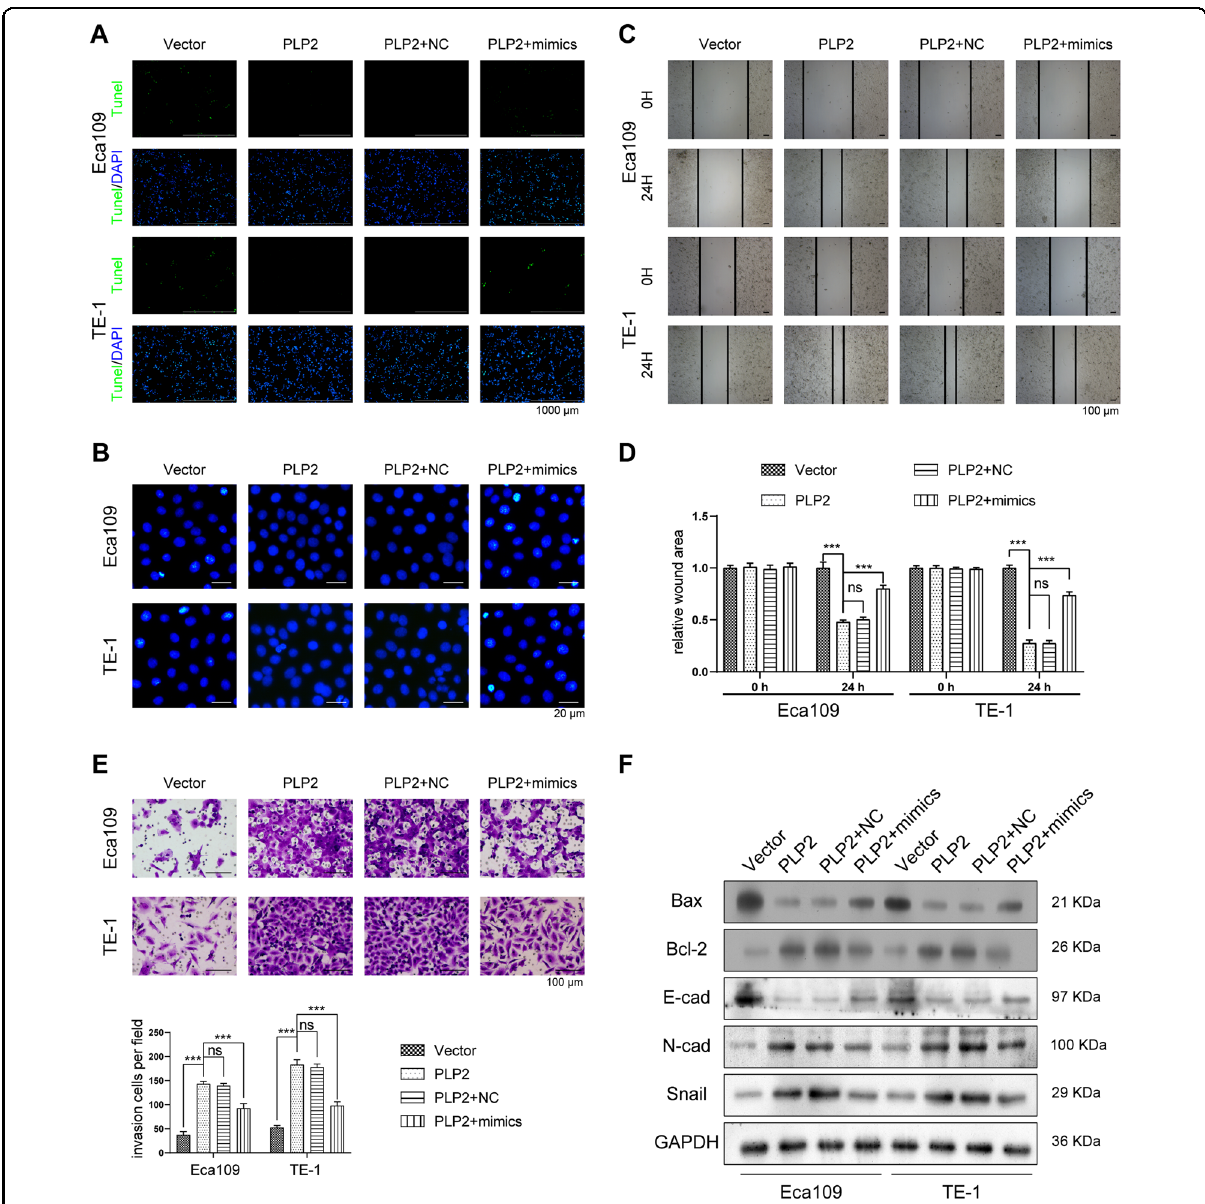
Fig. 5 Restoration of miR-124 weakened PLP2-caused ESCC cell metastasis and promoted cell apoptosis. After overexpression of PLP2 with or without miR-124 mimics transfection, the apoptosis of Eca109 and TE-1 cells was determined by A Hoechst staining, scale bars, 1000 μ m. B TUNEL assay, scale bars, 20 μ m. The ability of migration and invasion was estimated by C , D scratch wound assay, scale bars, 100 μ m. E transwell assay, scale bars, 100 μ m. F The key proteins in apoptosis pathway and EMT pathway analyzed by WB. ** p <